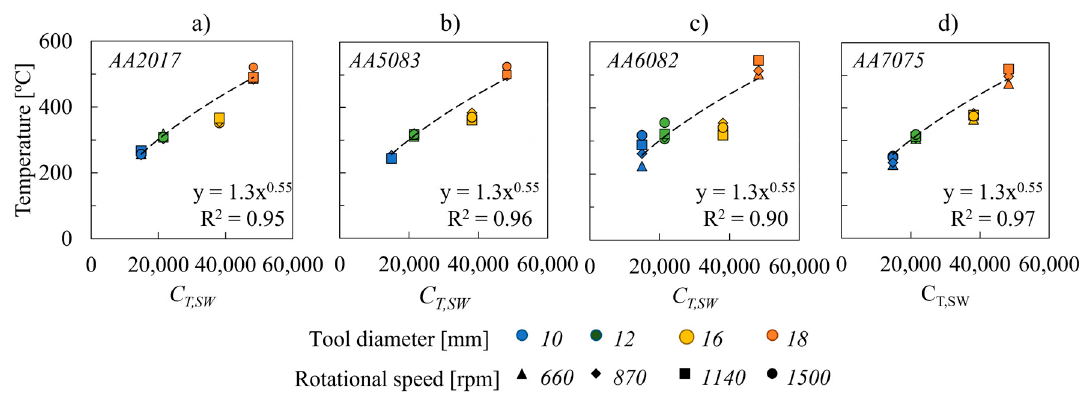
Figure 11. Evolution of temperature with the C T,SW coefficient for the ( a ) AA2017, ( b ) AA5083, ( c ) AA6082 and ( d ) AA7075 aluminium alloys.